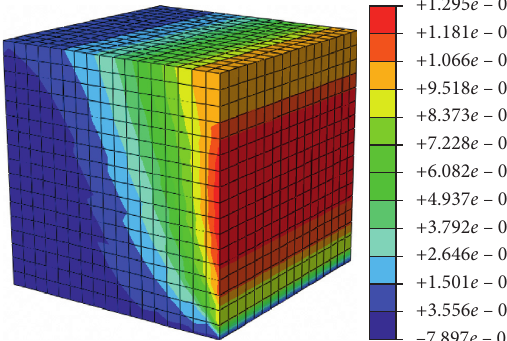
Figure 12: Vertical deformation contours of concrete (unit: